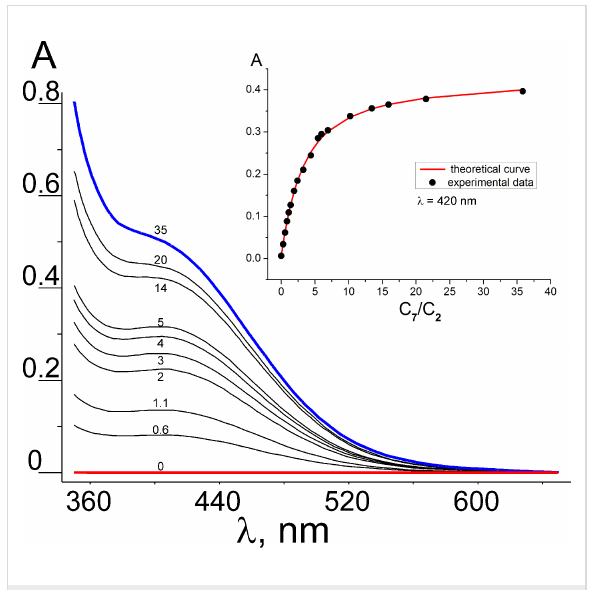
Figure 4: The changes observed in the UV–vis spectra during the titra- tion of clip 2 with paraquat ( 7 ) in acetonitrile at 20 °C. The labels near each plot correspond to the equivalents of paraquat ( 7 ) added.